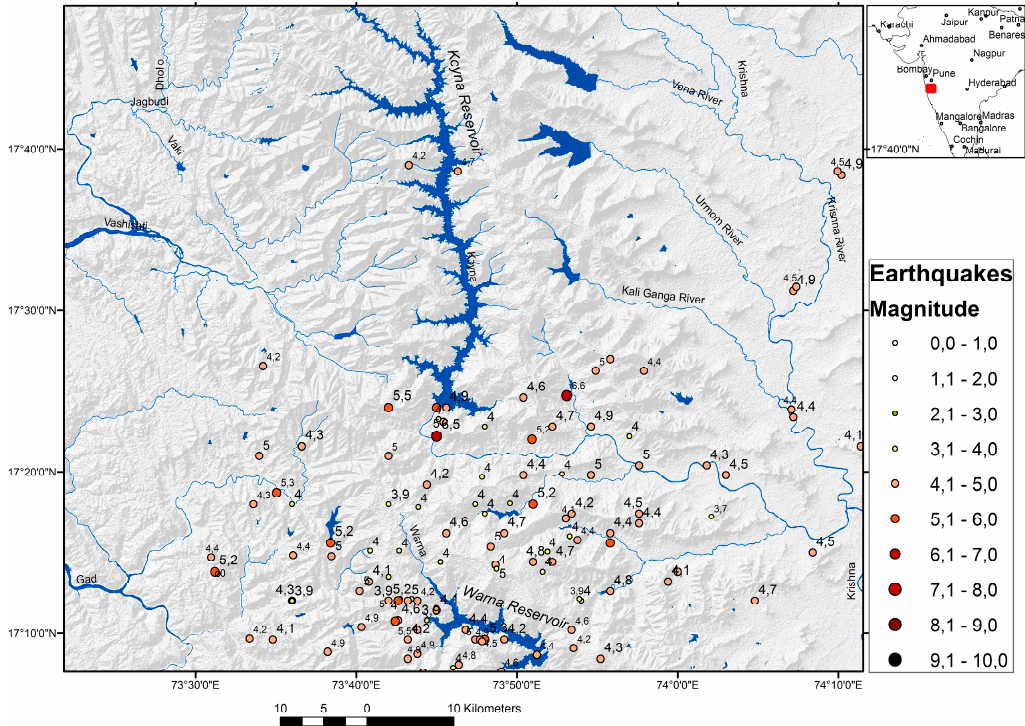
Figure 1. Overview of past seismic events. Source: Earthquake Catalogue of India [1,2], ISC [4], USGS [5], EMSC [6] and [7].